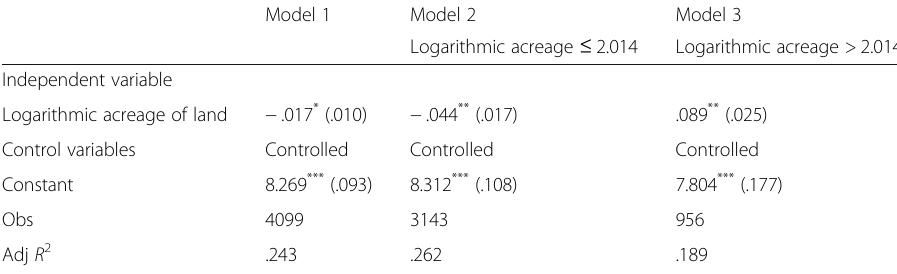
Table 4 OLS regression and threshold effect of land on income Model